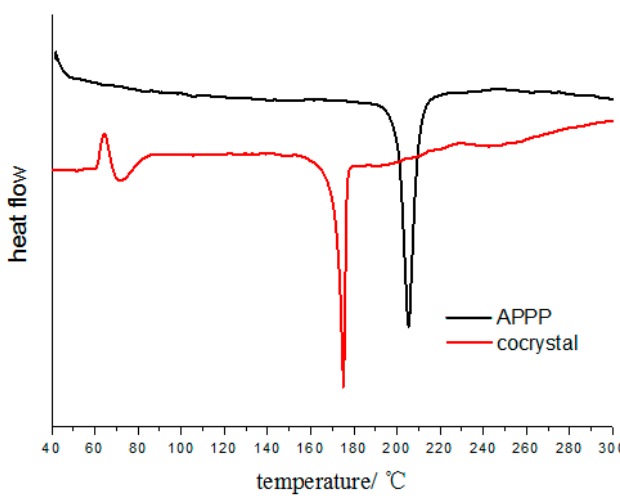
Figure 4. DSC patterns of the cocrystal and pure APPP.